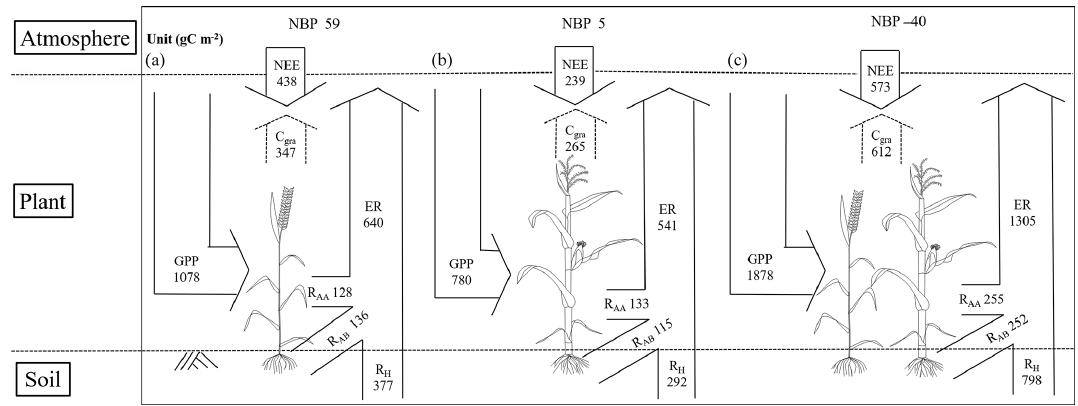
Figure 11. Carbon budget of wheat (a) , maize (b) and the full wheat–maize rotation cycle, with fallow periods included (c) . Note that the absolute value of NEE is shown here; NBPs of wheat and maize are the average of two independent methods (i.e, an eddy covariance-based method and a crop-sample-based